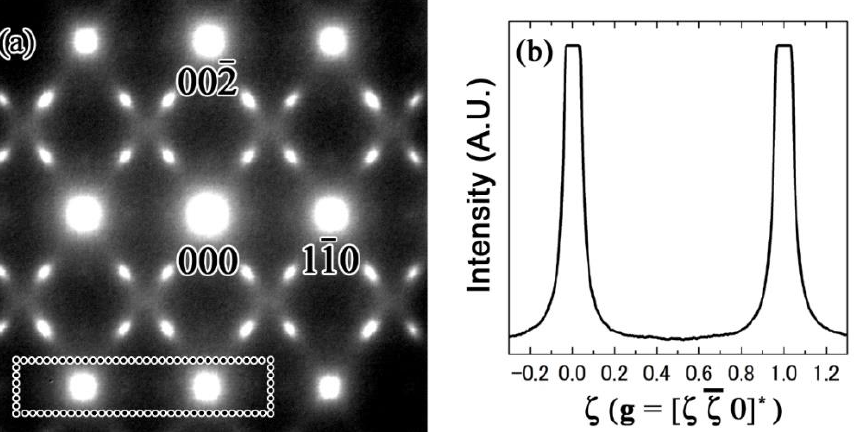
Figure 7. ( a ) SADP of the Zr-14 at.% Nb alloy (zone axis of [110]); ( b ) intensity profile along [1 ¯ 10].